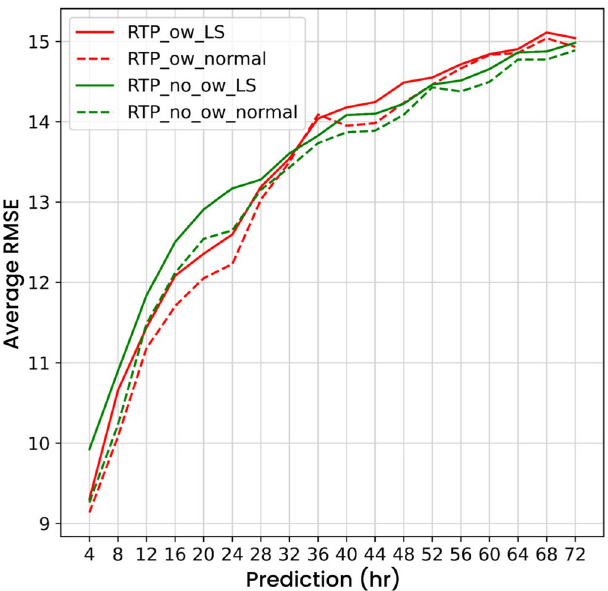
Figure 4. Average RMSE of LS stations (solid line) or normal stations (dashed line) in every prediction hour for RTP pre-trained with (RTP_ow) or without (RTP_no_ow) ocean